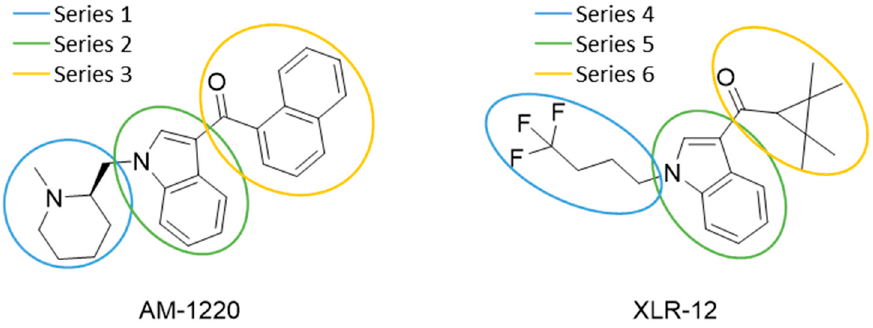
Figure 10. Bioisosteric replacement of selected compounds. The different studied parts of the molecules are highlighted in blue, green, and yellow.